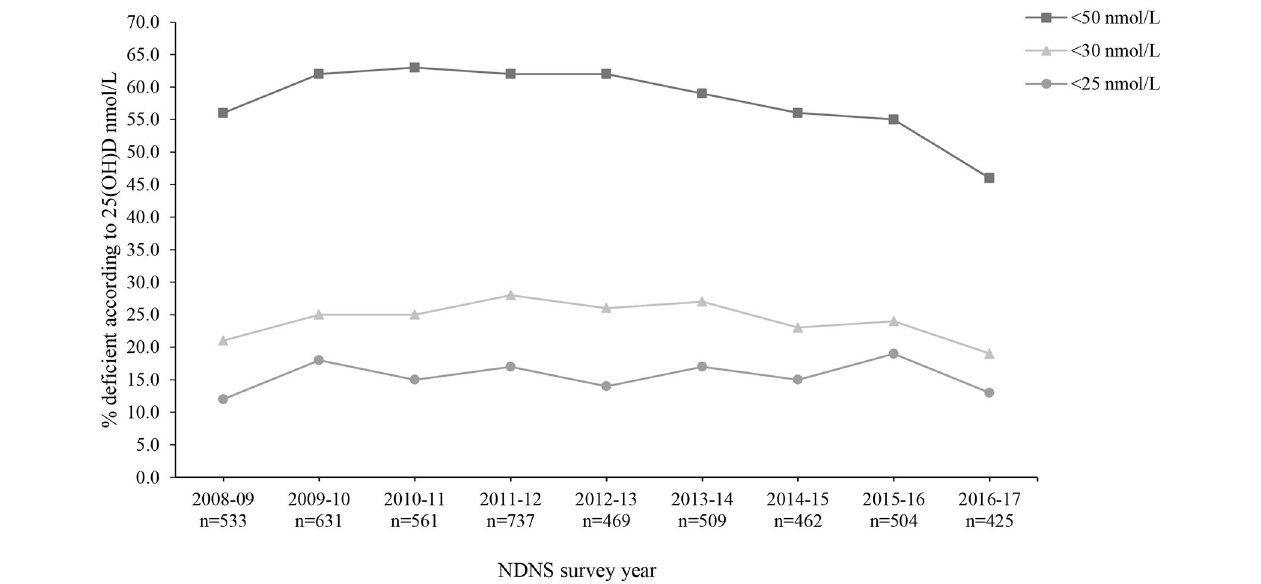
FIGURE 4 | Percentage (%) of participants from the UK National Diet and Nutrition Survey (NDNS) classified as vitamin D deficient based on The Endocrine Society and EFSA ( < 50 nmol/L), US Institute of Medicine ( < 30 nmol/L) and SACN ( < 25 nmol/L) cut-off values for 25(OH)D concentrations ( n = 4,831). UK, United Kingdom; EFSA, European Food Safety Authority; US, United States; SACN, Scientific Advisory Committee on Nutrition (UK); 25(OH)D, 25-hydroxyvitamin D; n , number of participants who provided blood